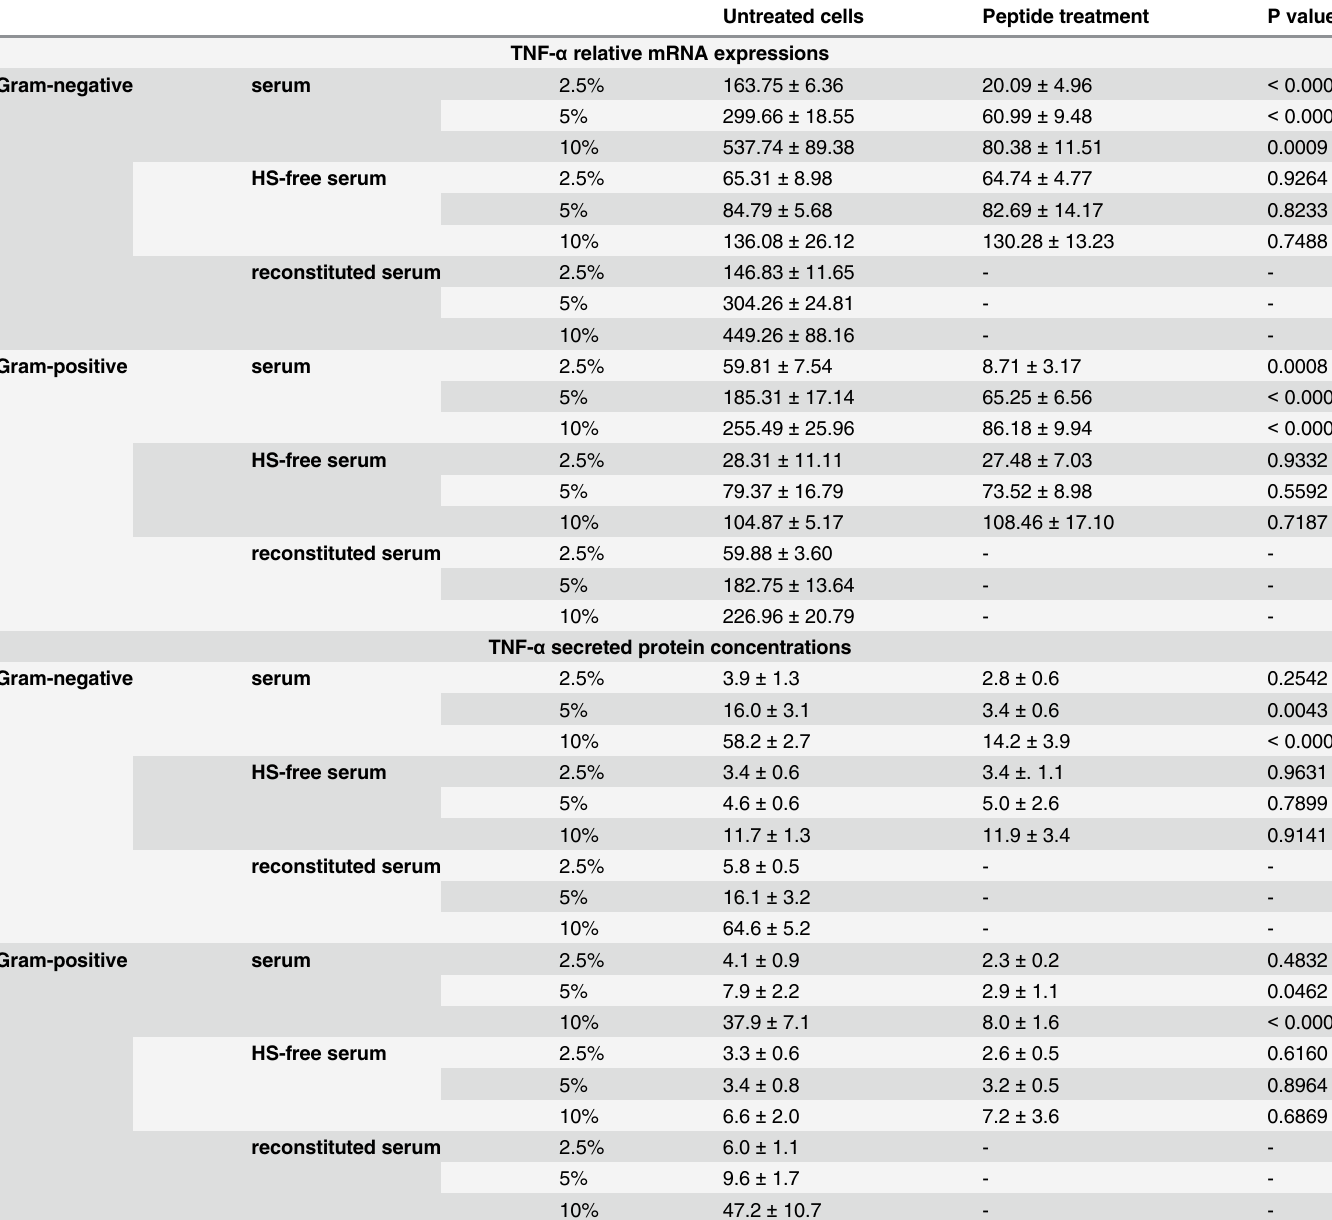
Table 2. TNF- α mRNA expressions and secreted protein concentrations of HL-1 cells stimulated with sera from patients with septic